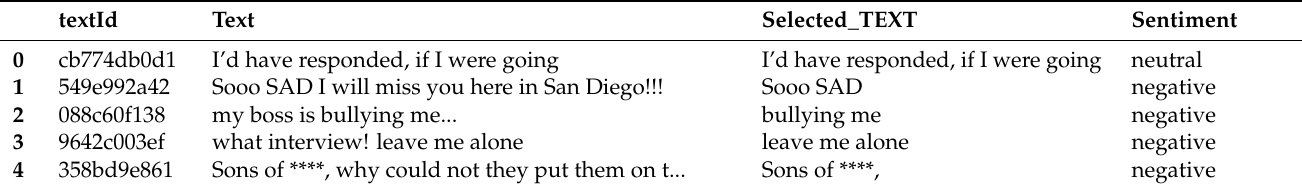
Table 4. Five samples from training dataset with meta